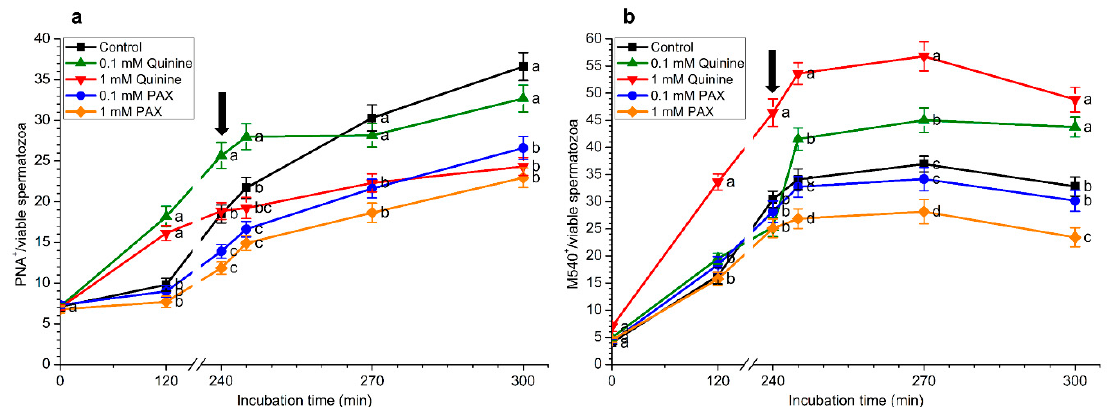
Figure 2. ( a ) Percentages of spermatozoa with an exocytosed acrosome (PNA − ) within the viable sperm population and ( b ) percentages of spermatozoa with high membrane lipid disorder (M540 − ) within the viable sperm population during in vitro capacitation and progesterone-induced acrosomal exocytosis (300 min) in the presence of 0.1 mM quinine, 1 mM quinine, 0.1 mM paxilline, (PAX), and 1 mM PAX. Black arrow indicates the time at which 10 µ g/mL progesterone was added to induce acrosomal exocytosis (i.e., 240 min). Different letters (a–c) mean significant ( p < 0.05) differences between treatments at a given time point. Data are shown as mean ± SEM for 15 independent experiments.